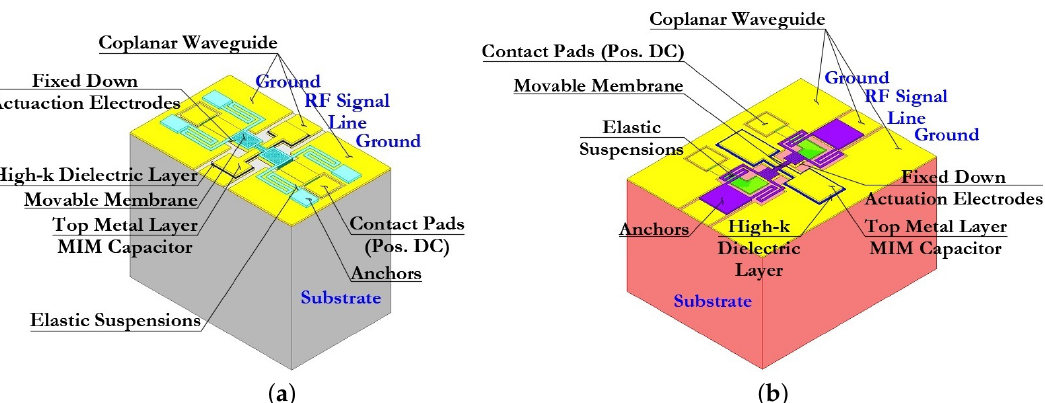
Figure 5. The isometric 3D topology of the developed capacitive RF MEMS switches: ( a ) switch (A); ( b ) switch